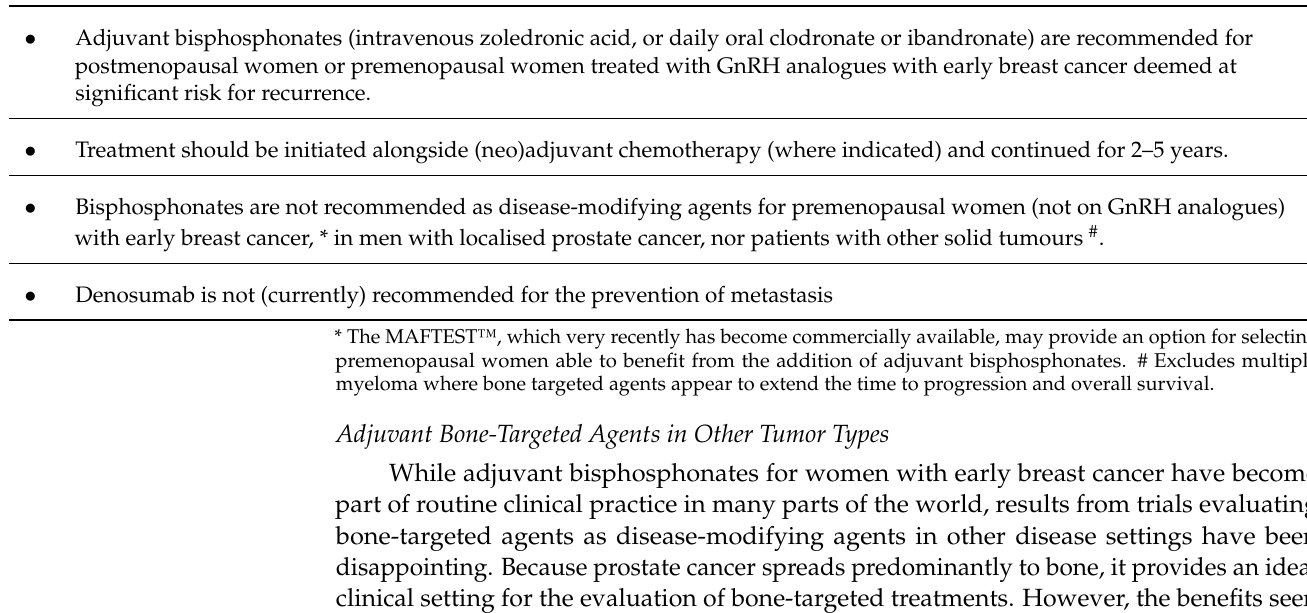
Table 2. Treatment recommendations for use of bone-targeted agents as disease-modifying agents in cancer